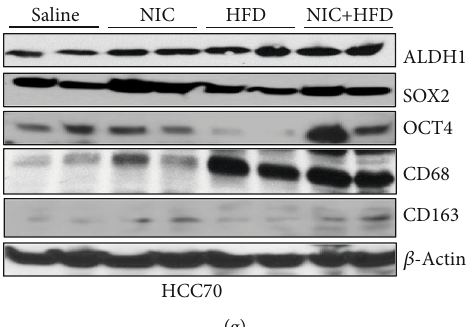
Figure 1: Coexposure to NIC plus HFD contributes to larger xenograft growth when compared to NIC or HFD alone. AA TN breast cancer cells HCC70 and HCC1806 (2 × 10 6 ) were implanted subcutaneously in nude mice prefed (two weeks) HFD (rodent diet with 60kcal % fat) and/or NIC (intraperitoneal injection twice/day, 0.75mg/kg/mice/injection). The xenografts were allowed to grow for 8 weeks in the mice continued on HFD, NIC, or NIC plus HFD, after which the mice were euthanized and tumors excised. (a) Representative HCC70 tumors from control saline, NIC, or HFD alone or in combination (NIC+HFD) at 8 weeks ( n = 5 ). (b) Weekly analysis of HCC70 tumor volume in various treatment groups. (c) Representative HCC1806 tumors from control saline, NIC, or HFD alone or in combination (NIC+HFD) at 8 weeks ( n = 5 ). (d) Weekly analysis of HCC1806 tumor volume in various treatment groups. (e) Quantitative gene expression analysis of Aldh1 , Sox2 , Cd68 , and Cd163 in HCC70 xenografts from various treatment groups, using human- (left panel) and mouse- (right panel) speci fi c primer sets. (f) Quantitative gene expression analysis of Aldh1 , Sox2 , Cd68 , and Cd163 in HCC1806 xenografts from various treatment groups, using human- (left panel) and mouse- (right panel) speci fi c primer sets. (g) Western blot analysis of xenografts for various macrophage and mammary cancer stem cell markers. ∗ p ≤ 0 : 05 and ∗∗ p ≤ 0 : 01 compared to saline or # p ≤ 0 : 05 and ## p ≤ 0 : 01 compared to the NIC group alone ( n = 3